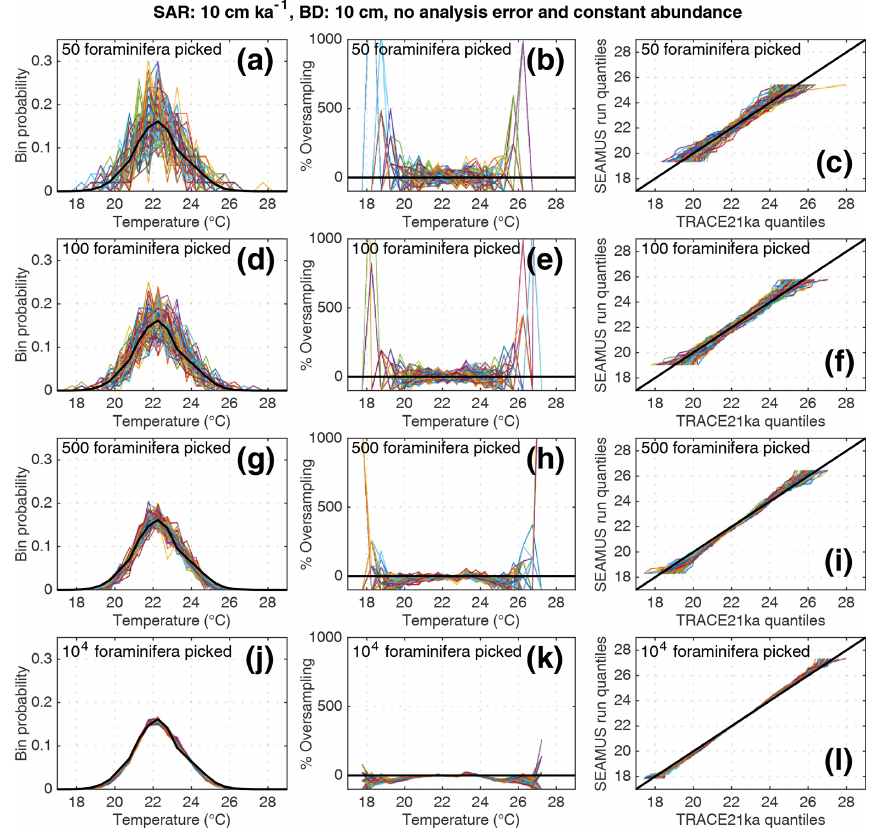
Figure 5. Simulated single foraminifera SST distributions from 100 ensembles of SEAMUS runs, with SAR of 10cmkyr − 1 , BD of 10cm, no analytical error and constant abundance. In each ensemble, the single foraminifera SST distribution from a single discrete depth with a simulated median age of 17.5ka is compared to the TRACE-21ka SST distribution for the 18 to 17ka period. The left panels (a, d, g, j) show the 100 SEAMUS ensembles as coloured lines in the case of 50, 100, 500 and 10 4 randomly picked foraminifera, with the TRACE-21ka SST distribution shown as a black line. The middle panels (b, e, h, k) show the rate of oversampling/undersampling for each of the 100 SEAMUS ensembles (coloured lines) relative to the TRACE-21ka SST distribution (black line) in the case of 50, 100, 500 and 10 4 randomly picked foraminifera. The right panels (c, f, i, l) show Q–Q plots of the 100 SEAMUS ensemble quantiles vs. the TRACE-21ka quantiles as coloured lines in the case of 50, 100, 500 and 10 4 randomly picked foraminifera, with a perfect 1:1 correspondence to TRACE-21ka shown for reference as a black